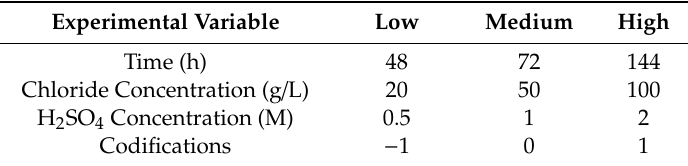
Table 3. Experimental parameters and codifications